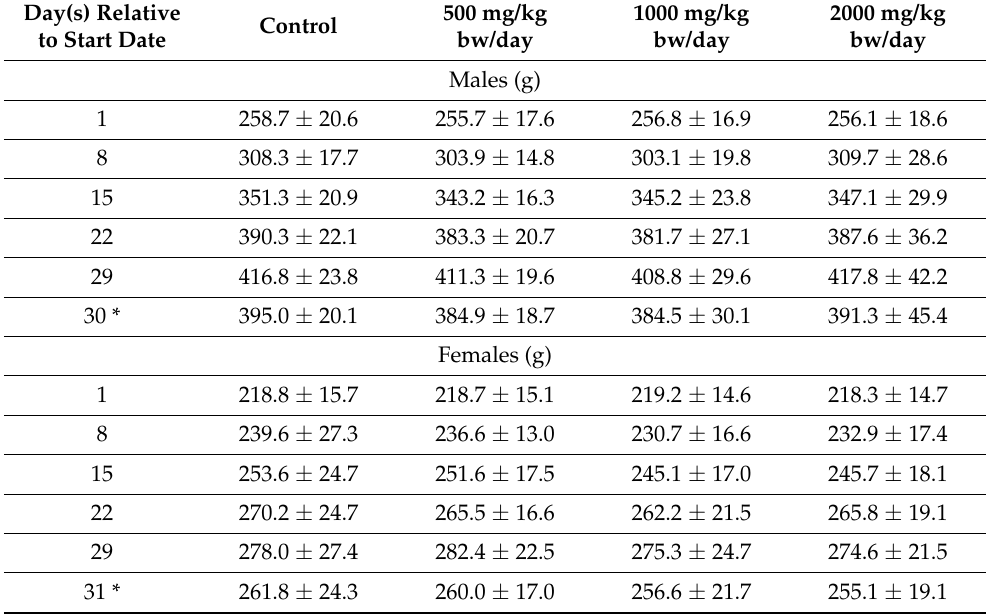
Table 1. Mean bodyweights for the 28-day repeat dose oral toxicity study with salidroside.